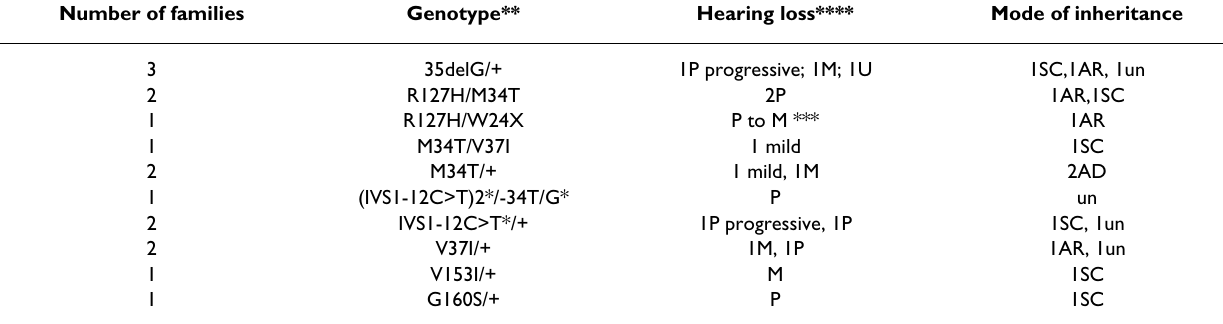
Table 2: GJB2 genotypes with unknown consequences in 16 families Number of